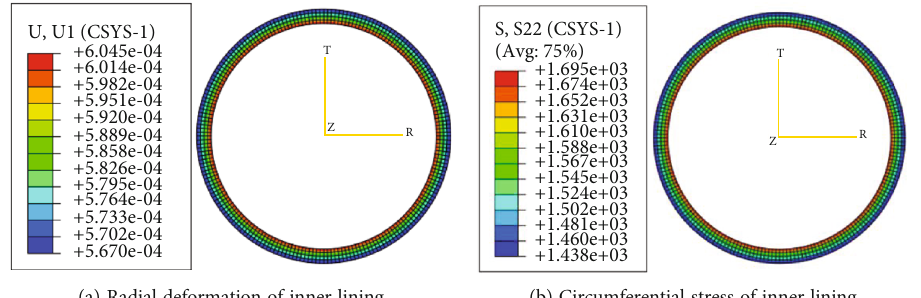
Figure 7: Radial deformation and circumferential stress of inner lining.